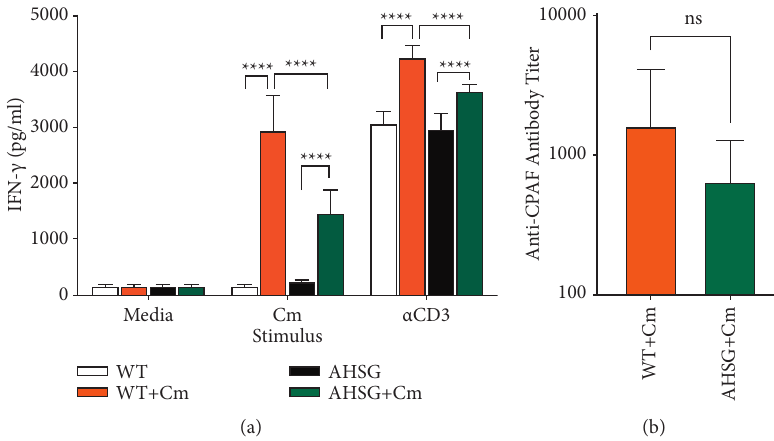
Figure 3: Regulatory role of fetuin-A in adaptive immunity following pulmonary Chlamydia infection. Age-matched wild-type (WT) C57BL/6 and fetuin-A-deficient AHSG mice were challenged intranasally with 500 IFU Cm. (a) Splenocyte IFN- c secretion ( n � 6 per group) from day 12 after Cm challenged animals stimulated with medium alone, UV-inactivated Cm, or anti-CD3 antibody. IFN- c was determined 72 hours poststimulation. (b) Antichlamydial protease-like activity factor (CPAF) elicited titers. Serum ( n � 6 per group) was collected at day 12 after Cm challenge. Preparation of splenocytes, IFN- c quantitation by sandwich ELISA, collection of serum, and determination of CPAF titer were carried out as described under “Materials and Methods.” Respective bars represent the mean ± SD. Differences between indicated groups were analysed by one-way ANOVA with Tukey’s multiple comparison test. ∗∗∗∗ P < 0 . 0001. ns, differences not statistically significant as determined by the two-tailed Student’ t